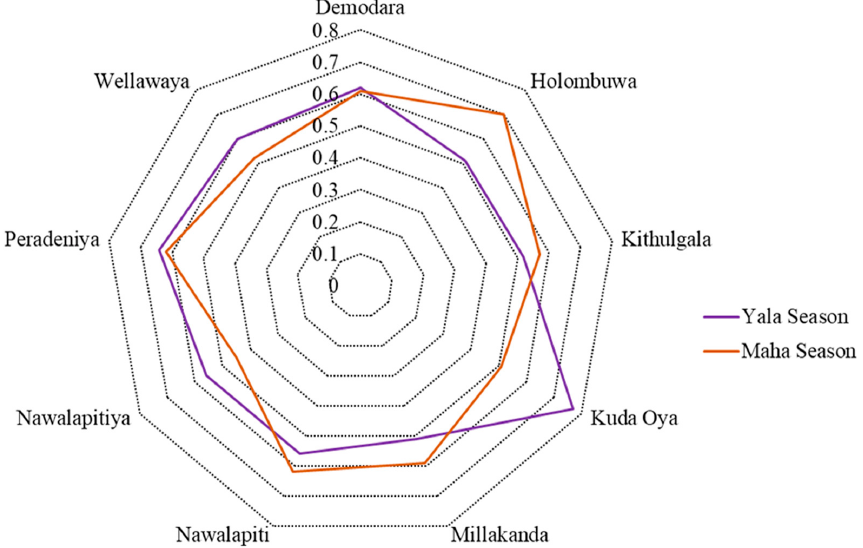
Figure 11. Evaluation of agCDI with SRI largely in the southwest parts of the districts for Yala and Maha